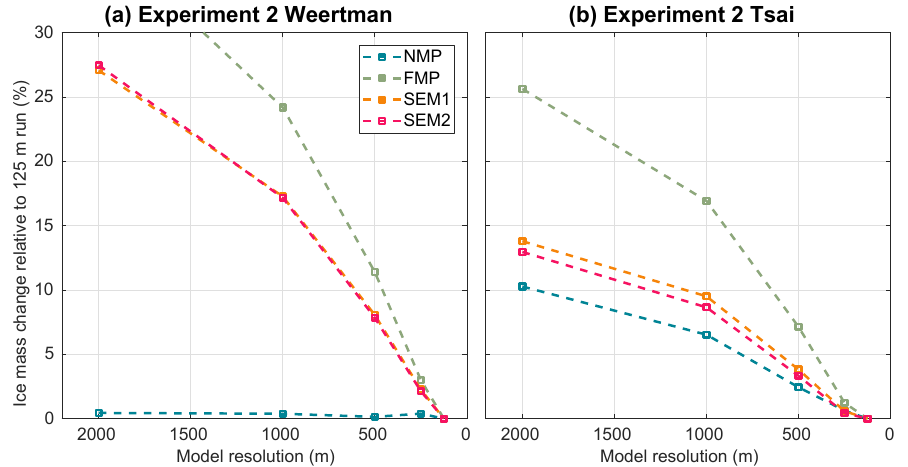
Figure 8. Convergence of ice volume above floatation at the end of experiment 2 as a function of mesh resolution. Absolute error relative to the corresponding 125 mesh resolution results (same friction law and melt parameterization scheme) for the Weertman (a) and Tsai (b) friction laws for the NMP (blue), FMP (green), SEM1 (orange), and SEM2